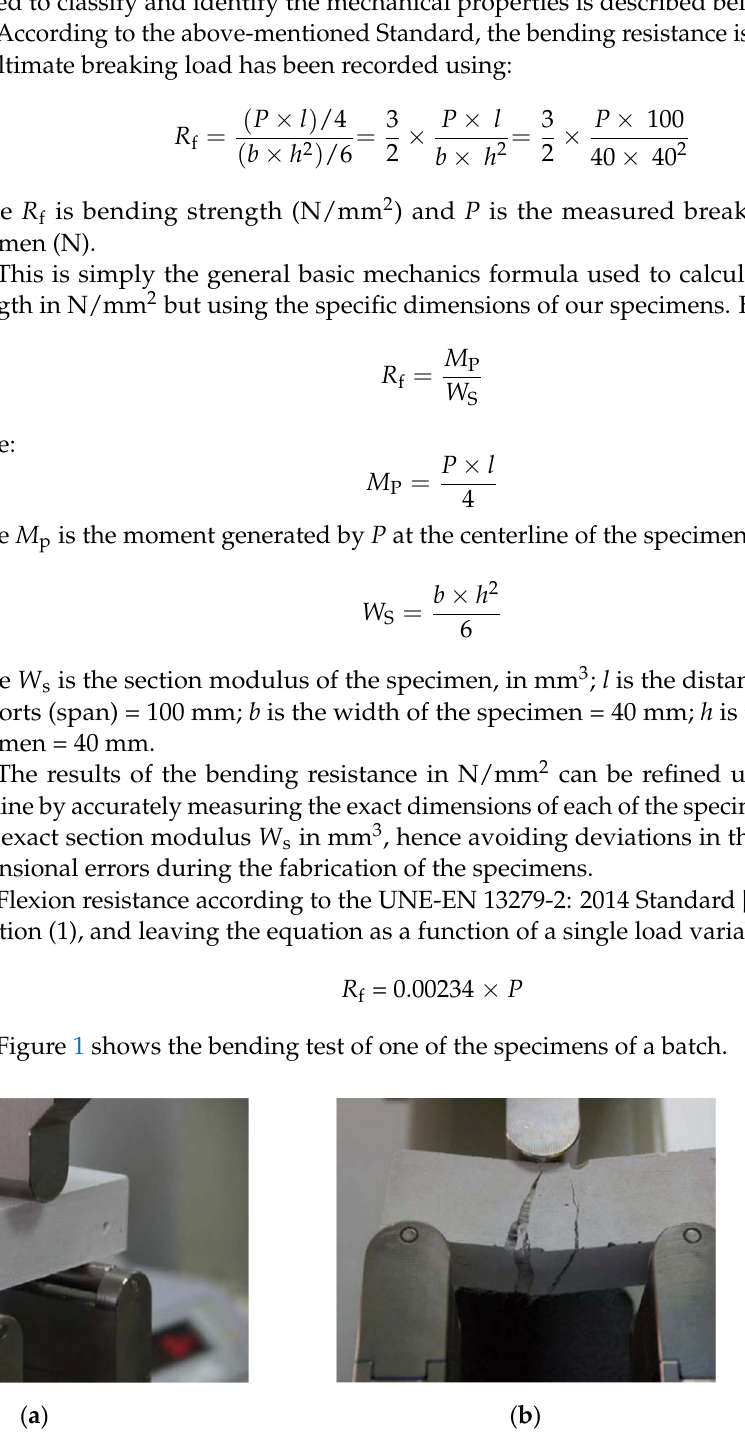
Figure 1. Flexible tested test tube, ( a ) is test tube to be tested, ( b ) is bending specimen rupture